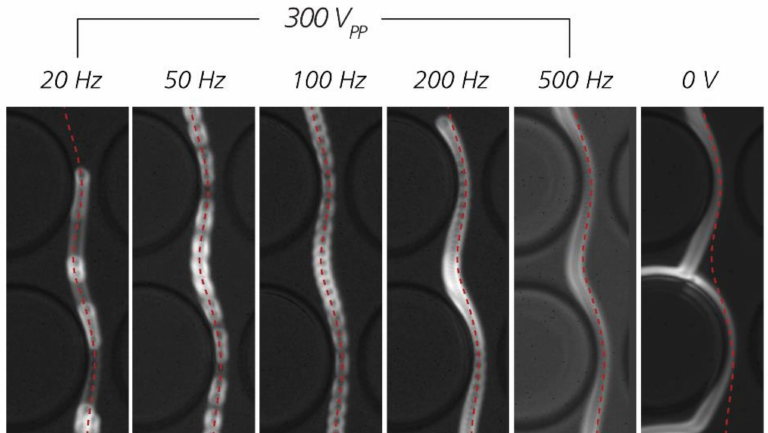
Figure 8. Comparison of trajectories of 2 µ m carboxylate beads #1 at di ff erent frequencies. Identical red dotted lines based on trajectory at 100 Hz have been added to the images to guide the eye. Device #2 ( D C = 2.3 µ m) was used. The applied pressure was 30 mBar. The medium was KCl 22 mS / m with 2.5% w / v polyvinylpyrrolidone (PVP). Similar to Pluronic ® 127, PVP helps reduce non-specific adsorption of the beads to the PDMS walls of the